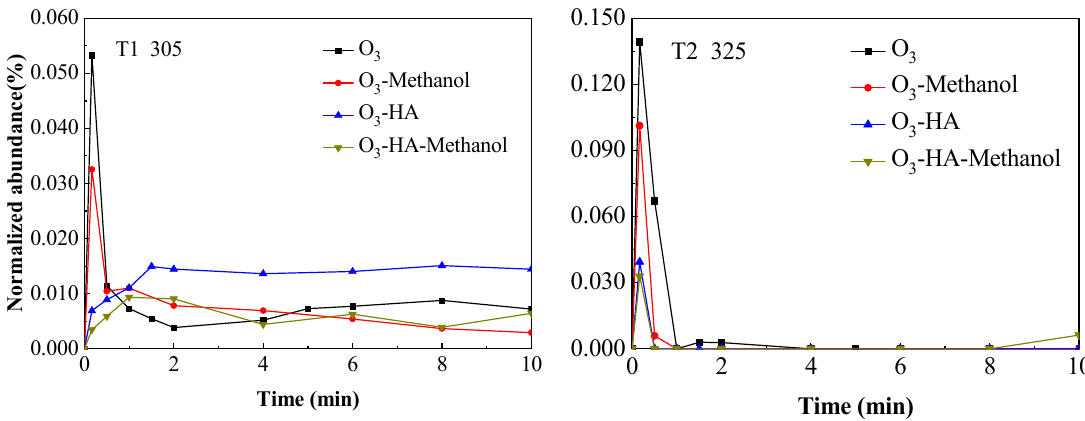
Figure3. FormationofcarbonylationproductsduringTMPozonation(initial TMP concentration = 10 mg / L, Figure 3. Formation of carbonylation products during TMP ozonation (initial TMP concentration = 10 initial pH = 6.0 ± 0.1, 20 ◦ mg/L, initial pH = 6.0 ± 0.1, 20 °C).